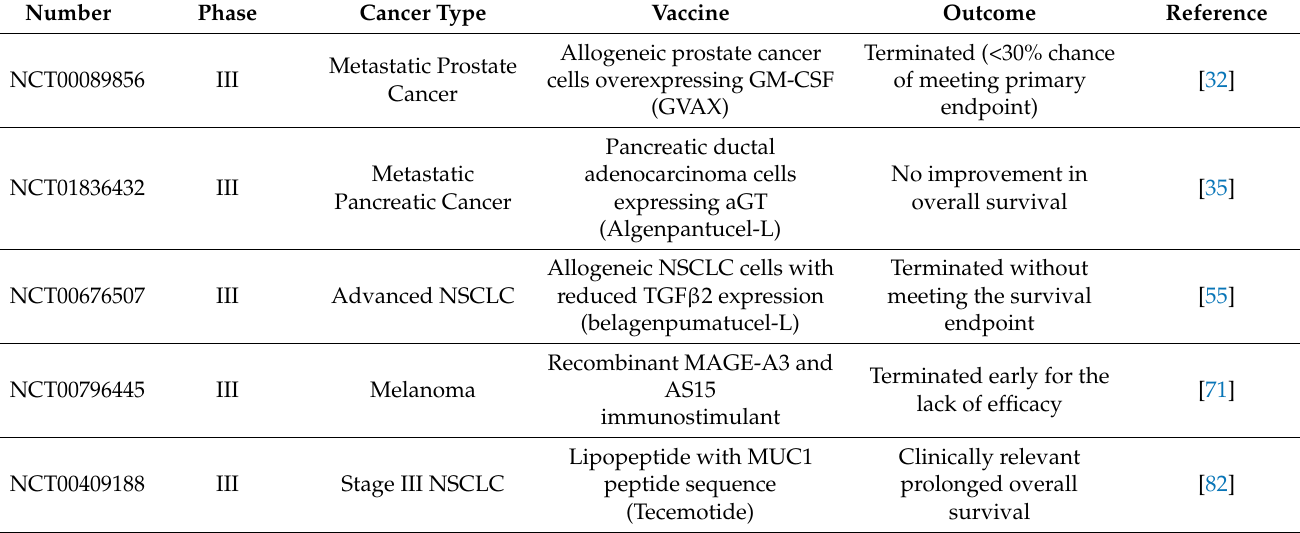
Table 2. Select clinical trials utilizing various cancer vaccine